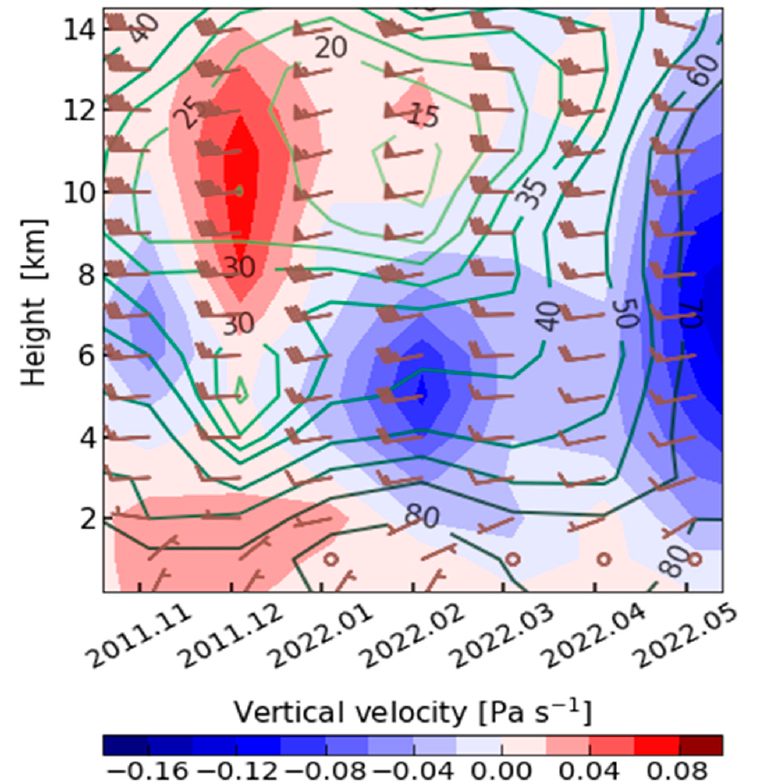
Figure 10. Variations of the monthly mean vertical velocity (shading, units: Pa · s − 1 ), horizontal wind (vectors, units: m · s − 1 ), and relative humidity (green contours, units: %) at the Shaowu city as a function of time and height, derived from ERA5 reanalysis (the ERA5 grid data used is located at 117.50° E, 27.25° N).